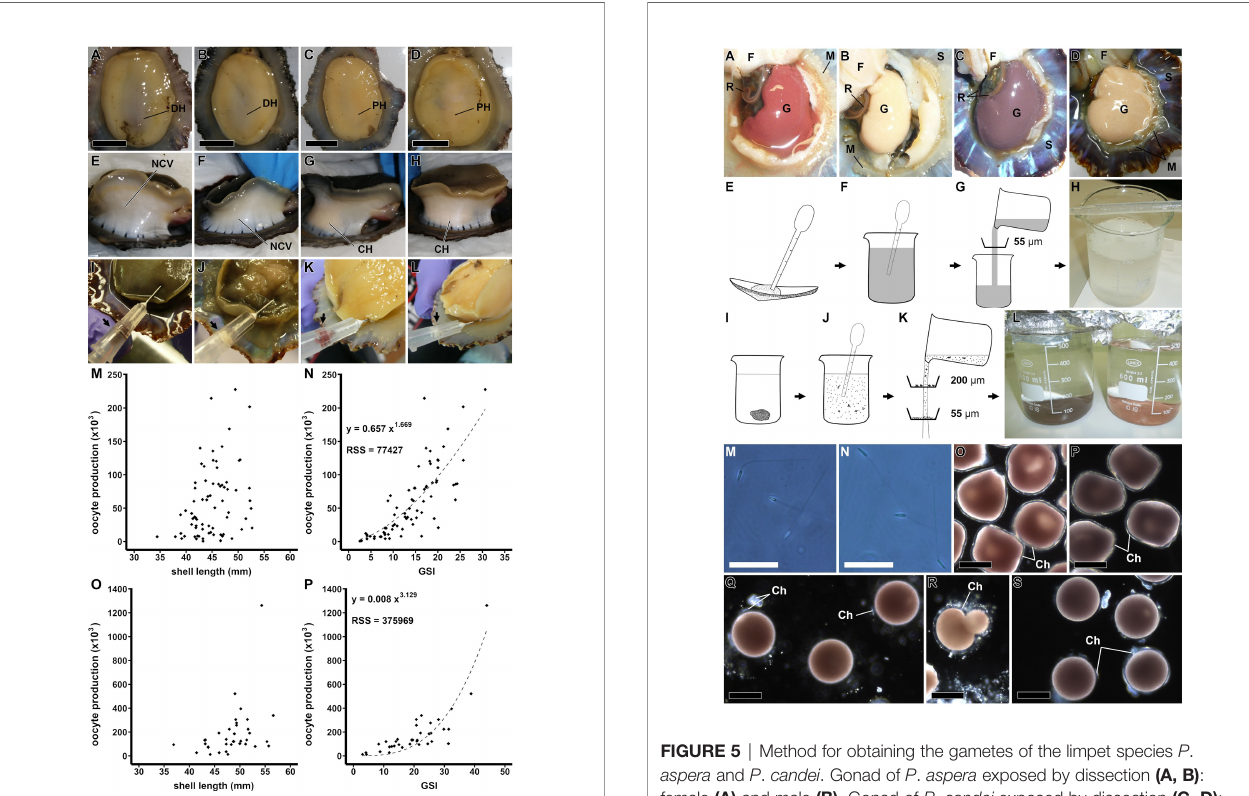
FIGURE 4 | Characters identi fi ed for the sex determination of limpets by visual examination. P. aspera , coloration of the ventral side of the foot when highly contracted (A – D) : females, dark hue (A, B) , and males, pale hue (C, D) . P. candei , coloration of the lateral-left side of the foot when highly extended (E – H) : females, no color variation (E, F) , and males, cream-color hue (G, H) . Biopsy as method to determine the sex in limpets. Biopsy realized through the ventral-left side of the foot in P . candei (I, J) : female (I) and male (J) . Biopsy realized through the left side of the foot basis in P . aspera (K, L) : female (K) and male (L) . Female fecundity as oocyte production (× 10 3 ) per specimen (M – P) . P . aspera (M, N) : oocyte production per female ordered by shell length (M) and by gonadosomatic index (N) . P . candei (O, P) : oocyte production per female ordered by shell length (O) and by gonadosomatic index (P) . Scale bar = 10 mm. CH, cream-color hue; DH, dark hue; NCV, no color variation; PH, pale hue.